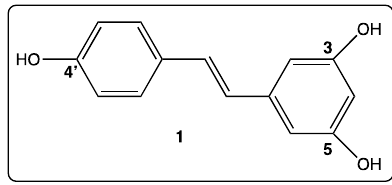
Figure 1. Structure of trans -resveratrol ( 1 ).